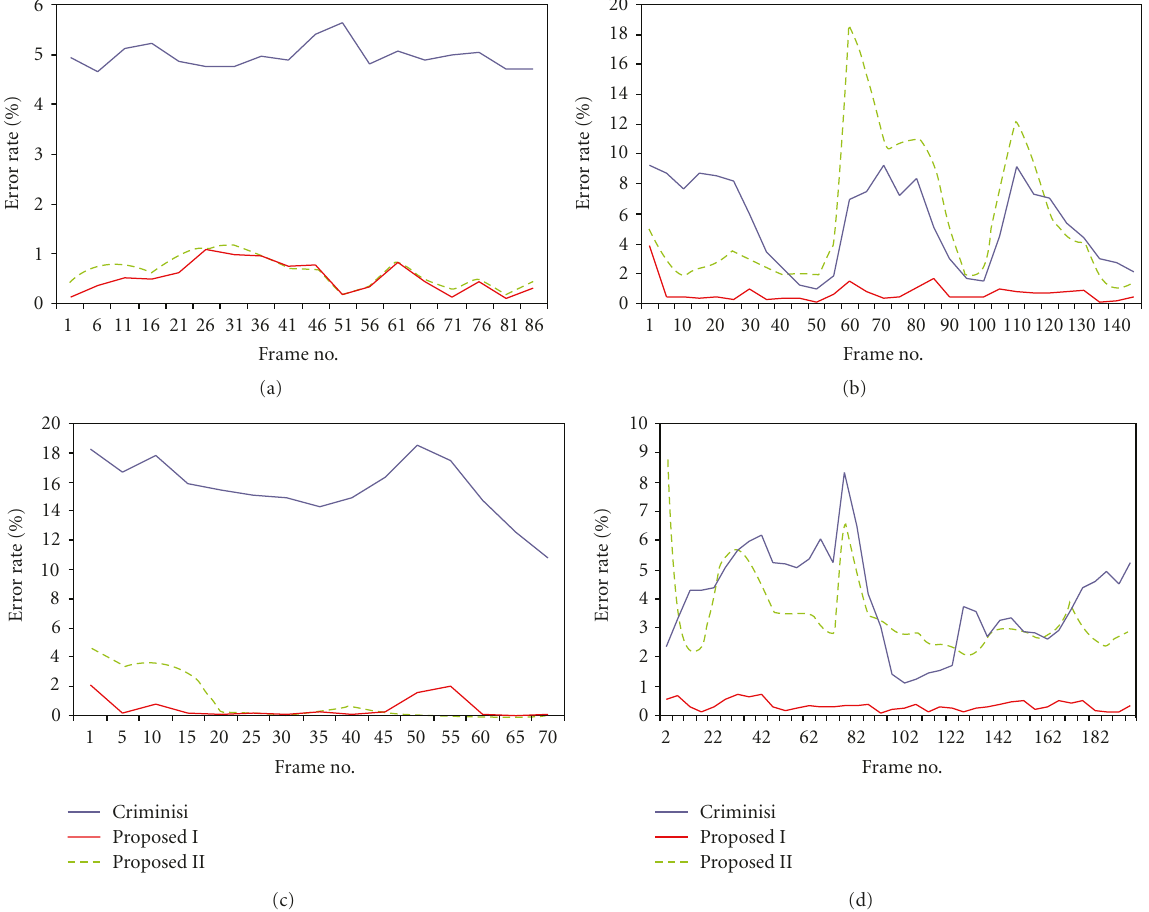
Figure 13: Comparison of the error rates on the (a) “Dolls,” (b) “Throwing Doll,” (c) “Moving Object and Background,” and (d) “Woman in Red”